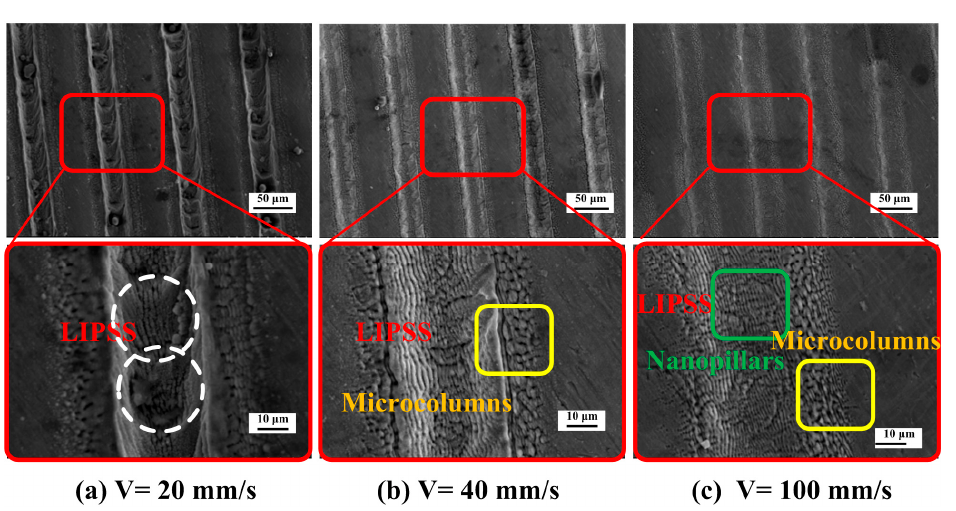
Figure 8. LIPSS induced on the Ti-6Al-4V surface with a laser energy density of 0.218 J/cm² and scanning speed of 40 mm/s. ( a ) Periodic ripples; ( b ) enlarged view, ×1500; ( c ) enlarged view, ×13,000.